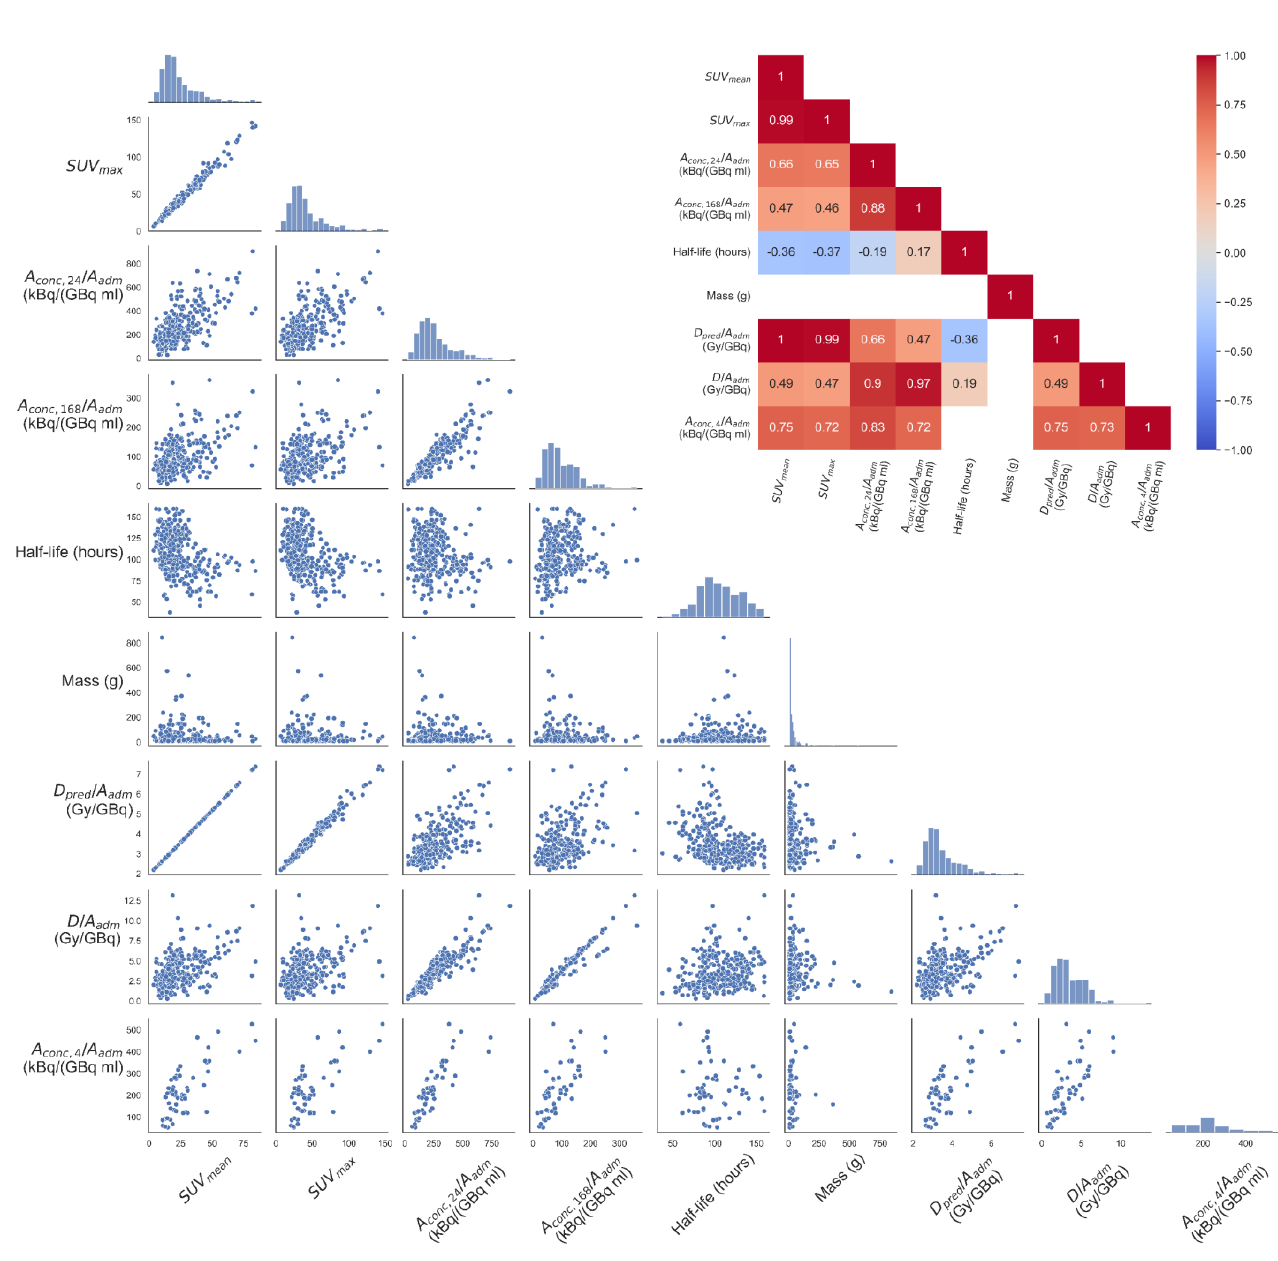
Figure 3. All parameters shown as scatter plots and their distribution on the diagonal. The inset heatmap shows the Pearson correlation coefficient where a significant linear correlation between parameters was found. The full data set is shown, and the predicted absorbed doses are based on the full data